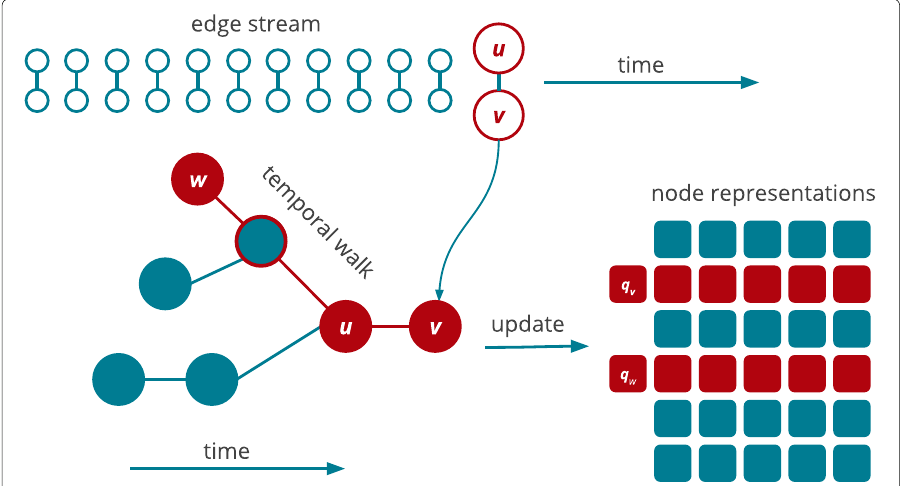
Fig. 1 Concept of StreamWalk. When uv edge arrives in the stream, vertices from the temporal neighborhood of u are sampled via temporal random walks. The method optimizes for the similarity of v and the sampled node